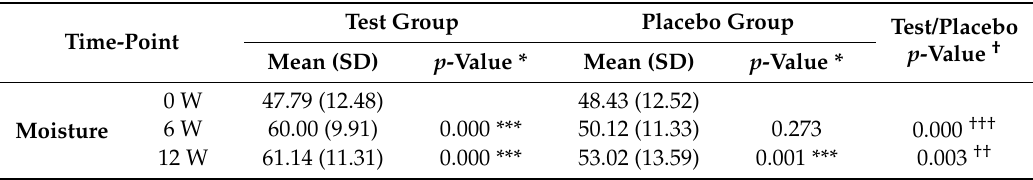
Table 4. Skin-hydration values measurement by Corneometer CM825.